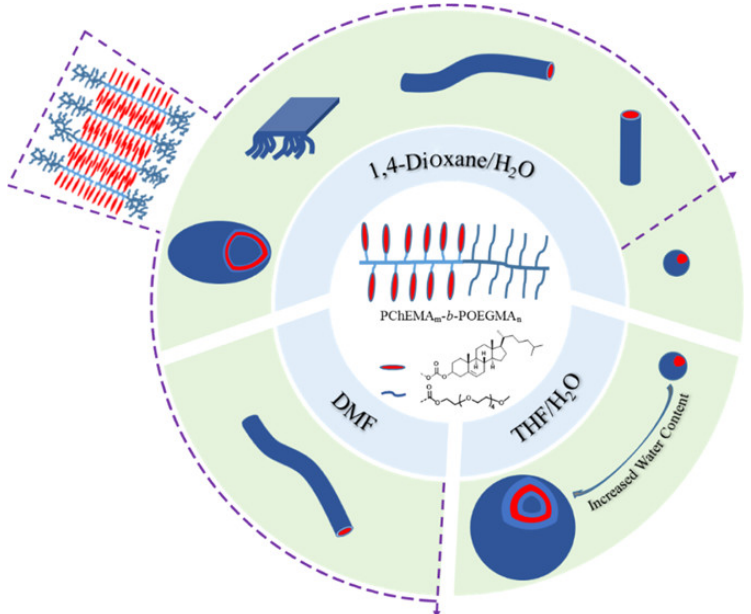
Figure 5. The adaptable nature of the cholesterol-bearing diblock BCP allows it to self-assemble into a plethora of structures in different solvents and concentrations. Reprinted with permission from Li et al., Langmuir , 2018 , 34 , 11034–11041